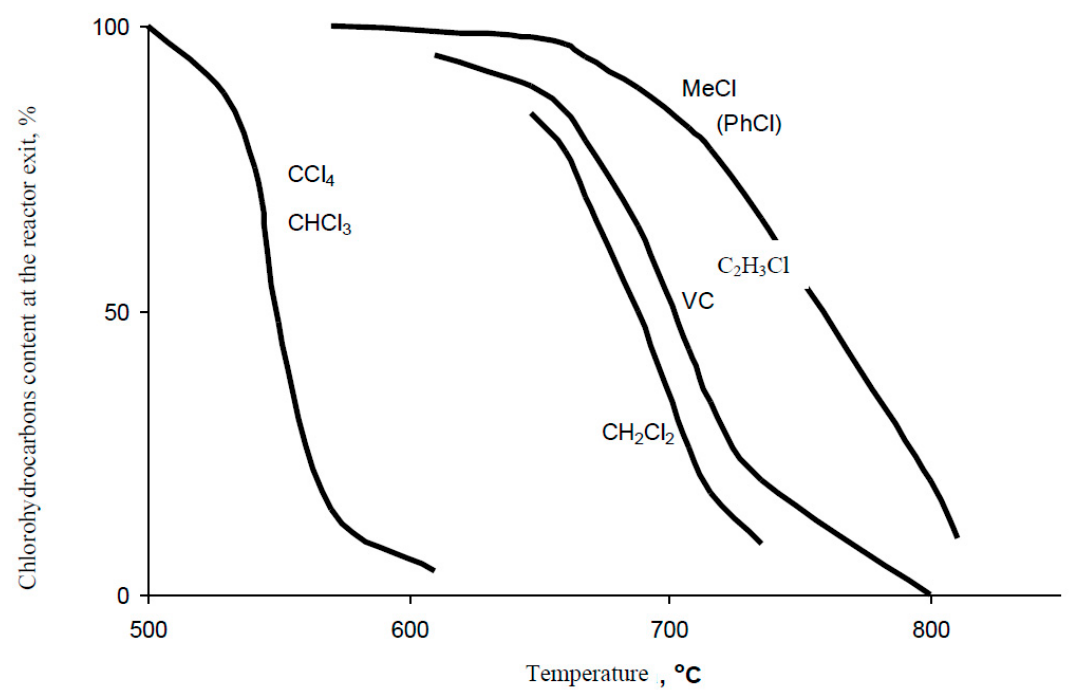
Figure 3. Chlorohydrocarbon reactivity in the process of thermal hydrodechlorination. Hydrogen excess, atmospheric pressure, residence time 11 s.